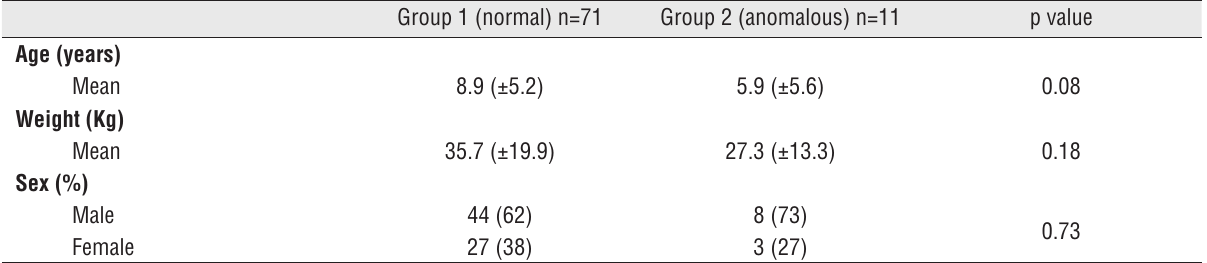
Table 1A - Baseline: Demographic data.